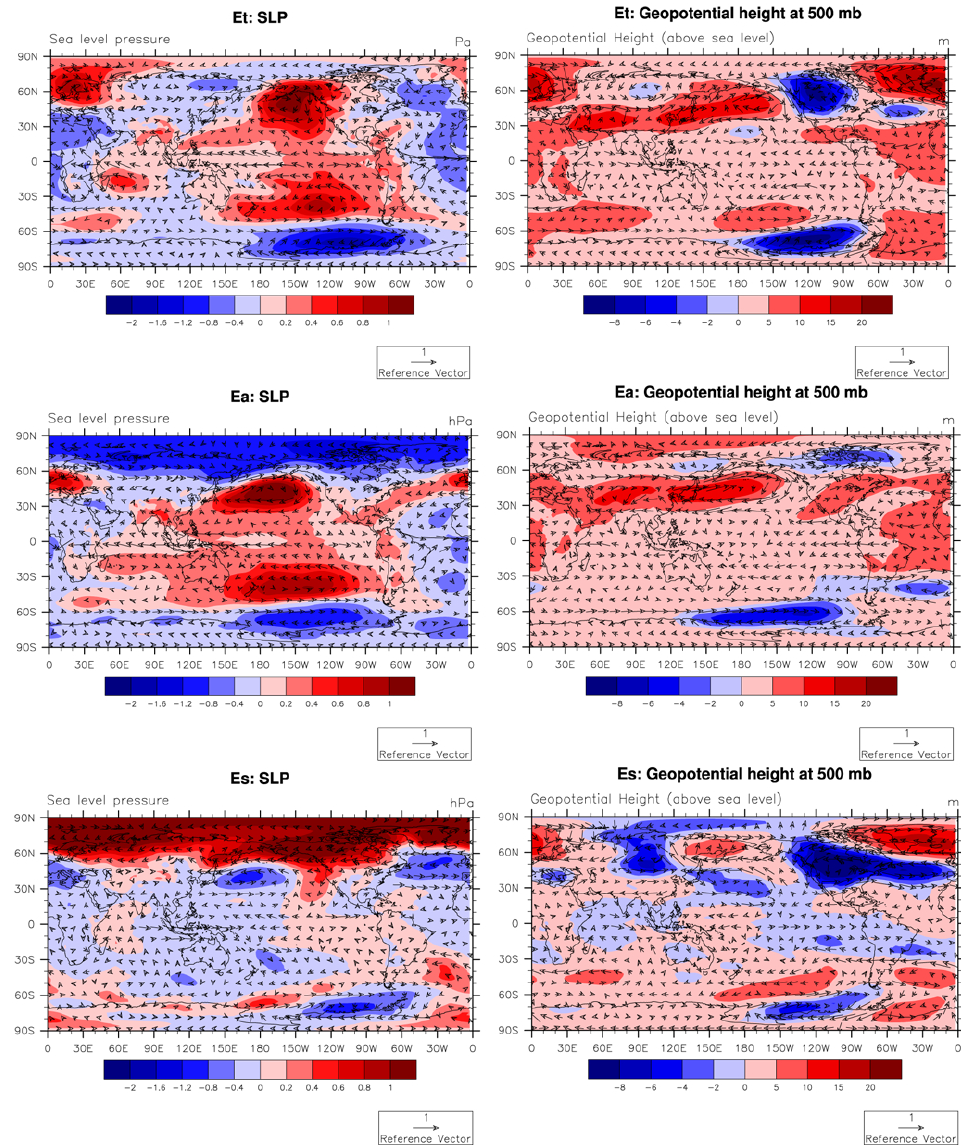
Fig. 6. Changes in SLP and horizontal winds at 850mb (left column) and changes in geopotential height and horizontal winds at 500mb (right column). The unit is hPa for SLP, ms − 1 for horizontal winds and m for geopotential